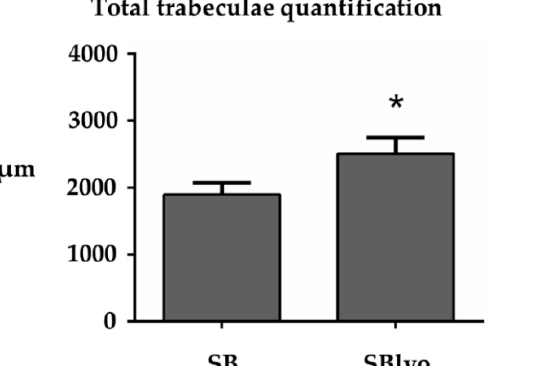
Figure 8. Trabeculae quantification. The neo-trabeculae are visible as red filaments (indicated by the red arrows). “*” indicates a significant difference between SB and SBlyo ( p < 0.05).